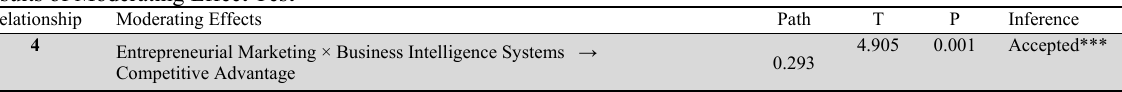
Results of Moderating Effect